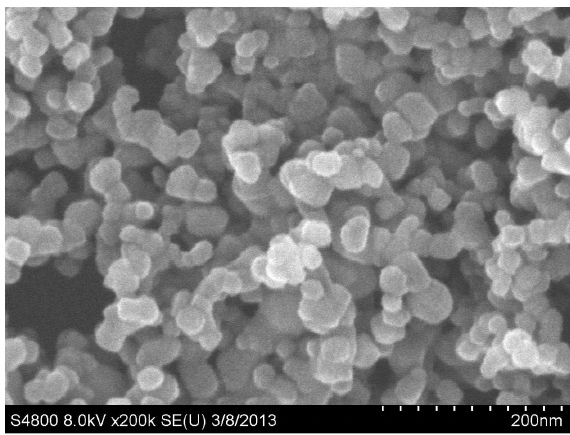
Figure 1. The image of TiO 2 NPs was captured by SEM.